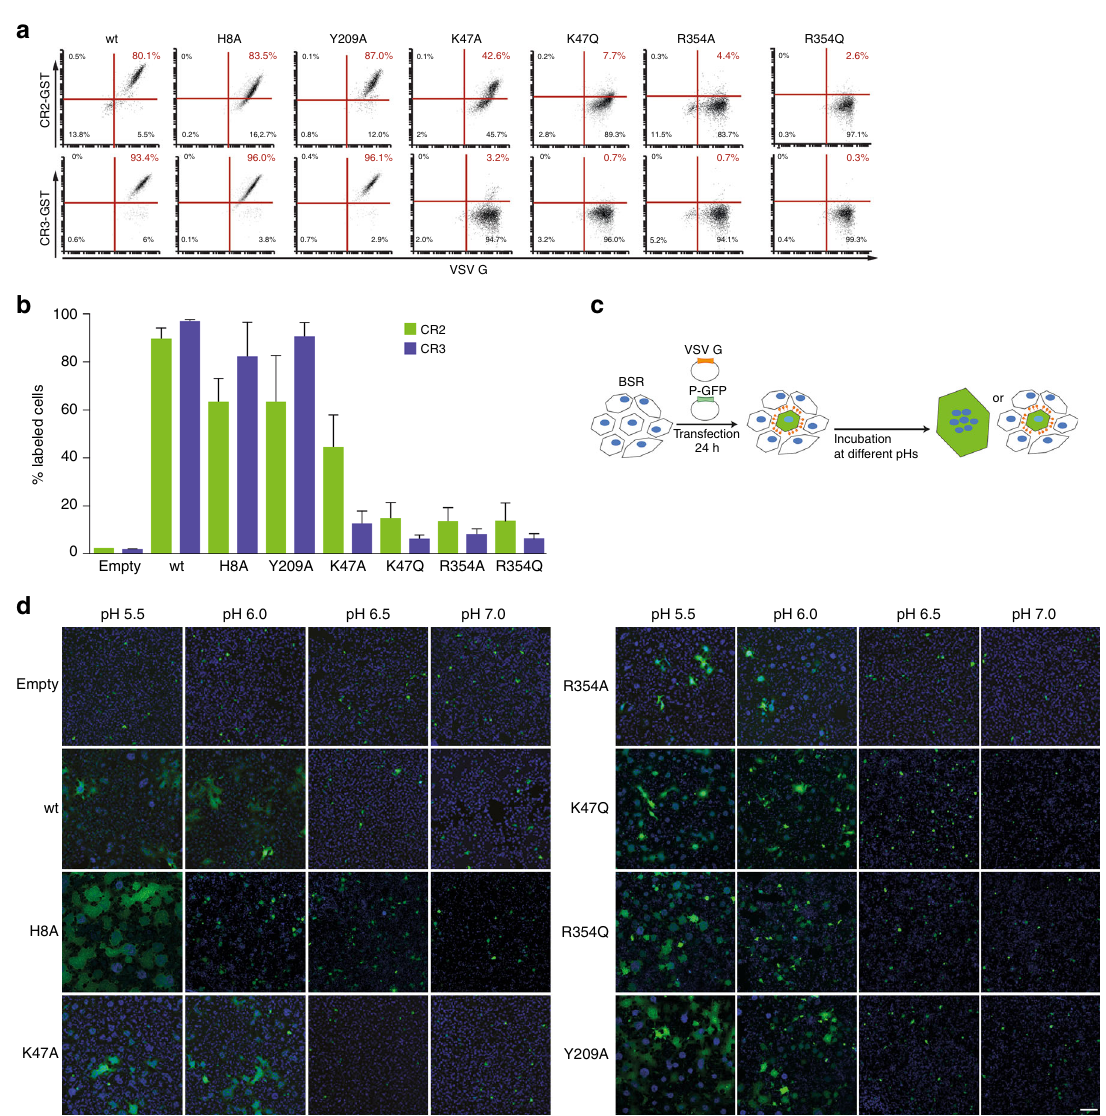
Fig. 5 K47 and R354 on G are crucial for interaction with CR domains but not required for fusion. a Flow cytometry analysis of the expression of WT and mutant glycoproteins at the surface of HEK293T cells and of the binding of fl uorescent GST-CR2 (top) and GST-CR3 (bottom). After 24 h of transfection, cell surface expression of WT and mutant G was assessed using monoclonal anti-G antibody 8G5F11 directly on living cells at 4 °C during 1 h. Cells were then incubated simultaneously with anti-mouse Alexa fl uor 488 and the indicated GST-CR ATTO550 . Cells transfected with a G construct that was still able to bind GST-CR proteins exhibited red fl uorescence due the ATTO 550 dye. In each plot, the percentage of ATTO 550 positive cells is indicated. b WT and mutant G ability to bind CR domains. The histogram indicates the mean percentage of ATTO 550 positive cells for each point mutation on G ( n = 3). The error bars represent the standard deviation. c Cartoon describing the cell – cell fusion assay. BSR cells are co-transfected with plasmids expressing VSV G (either WT or mutant G) and P-GFP. After 24 h of post-transfection cells are exposed for 10 min to media adjusted to the indicated pH which is then replaced by DMEM at pH 7.4. The cells are then kept at 37 °C for 1 h before fi xation. Upon fusion, the P-GFP diffuses in the syncytia. d Cell – cell fusion assay of WT and mutant glycoproteins. Scale bar = 200 µ